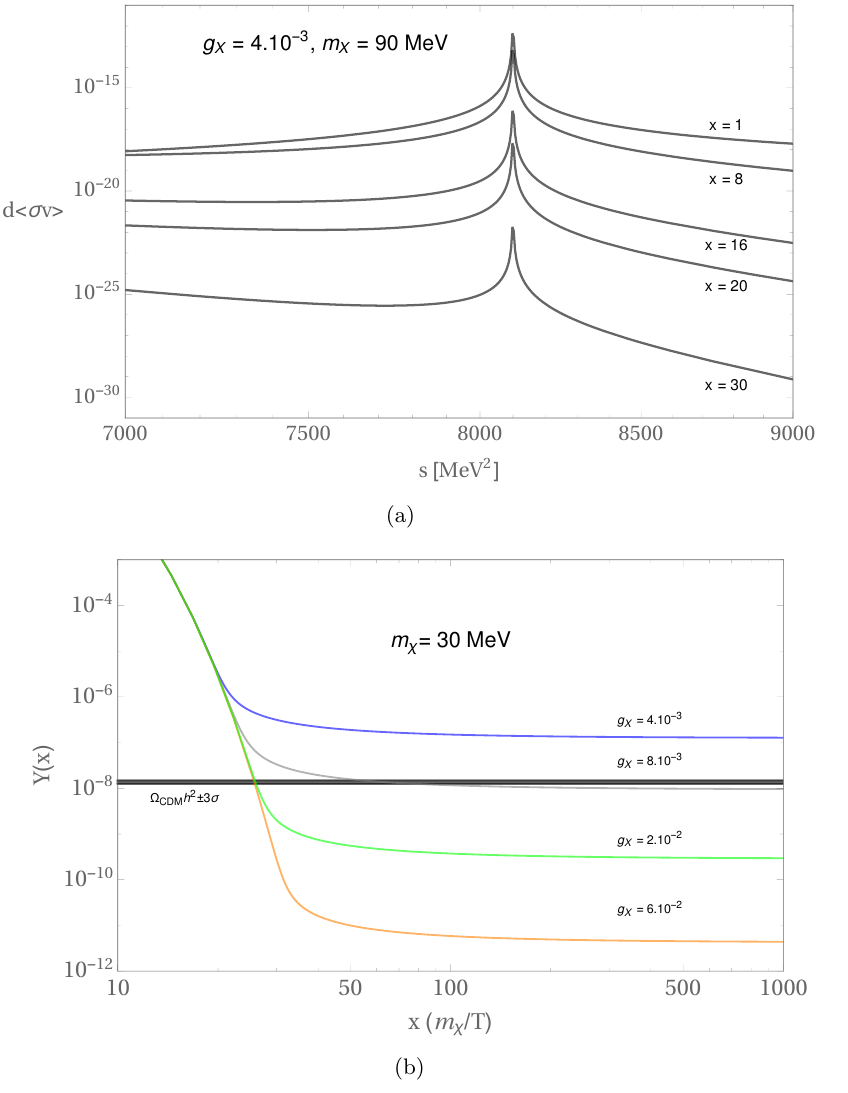
Figure 7 . (a) The di(cid:11)erential thermal average dominated by a narrow resonance. In the example, the X boson mass is m X = 90 MeV, while the dark fermion mass is m (cid:31) = 30 MeV. In (b), the horizontal black band presents the 3 (cid:27) region allowed by the current measurement of cold dark matter density. The abundance Y 0 is sensitive to small variations of the coupling constant g X , such that (cid:10) CDM provides a strong bound for SM (cid:10) U(1) X theories. The remaining parameters are